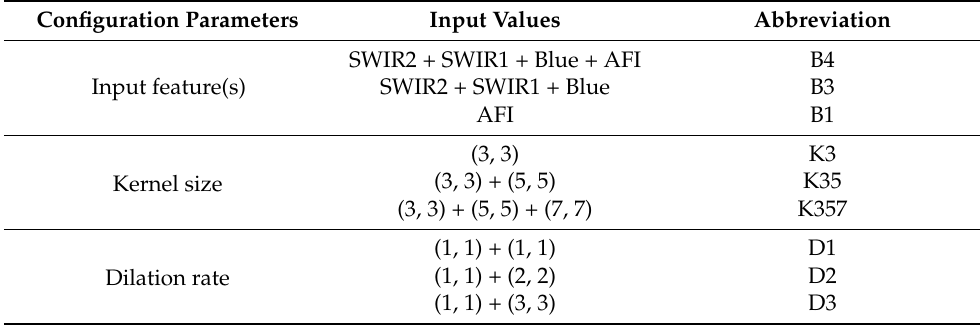
Table 1. Different architecture parameters to configure